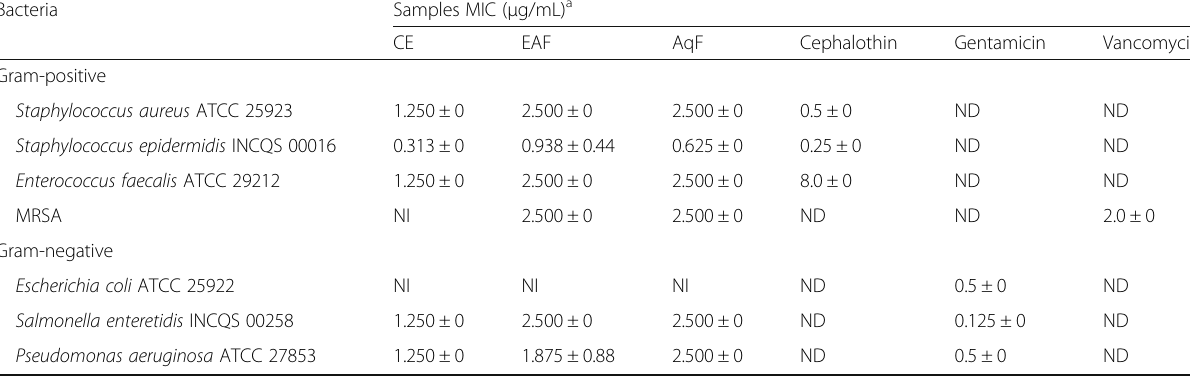
Table 2 MIC of the CE and fractions of E. uniflora Linn against gram-positive and gram-negative bacteria